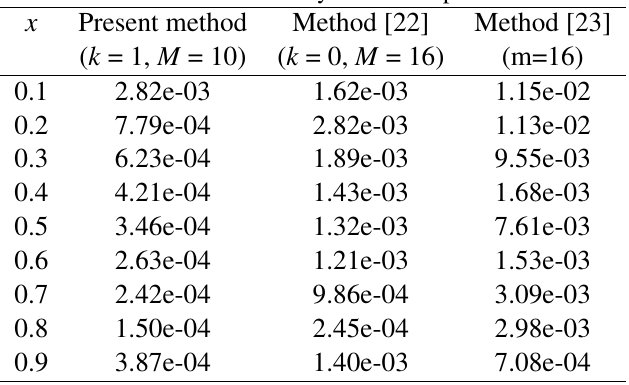
Table 7 Error analysis of example